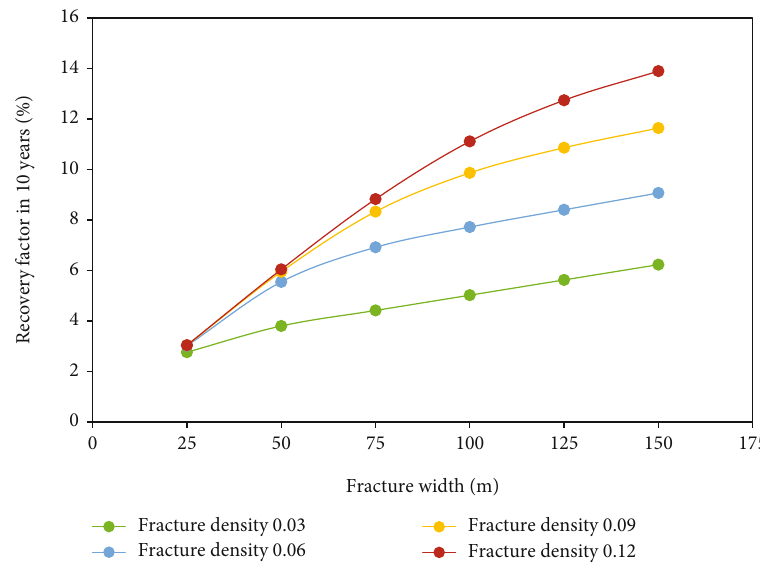
Figure 13: Relationship between the fracture width and the oil recovery